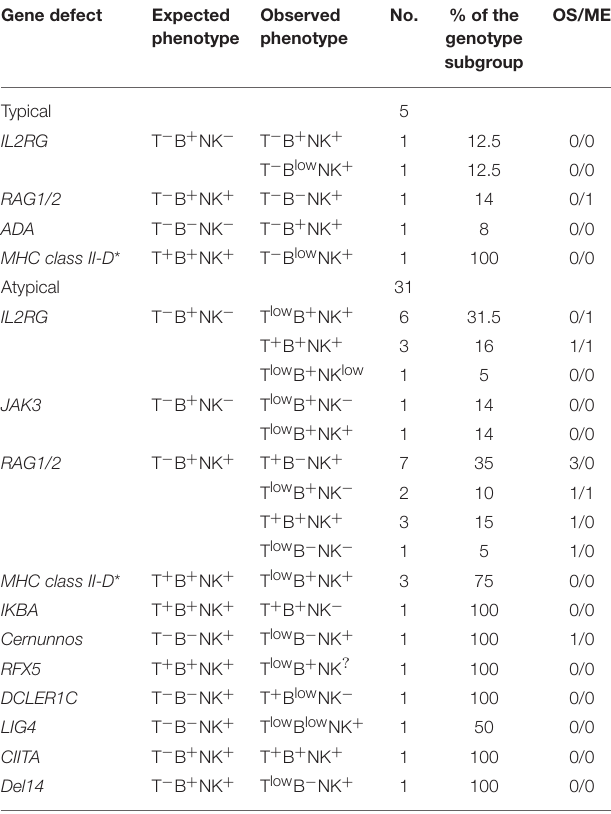
TABLE 4 | SCID patients with known gene defect and discordant immunophenotype. Gene